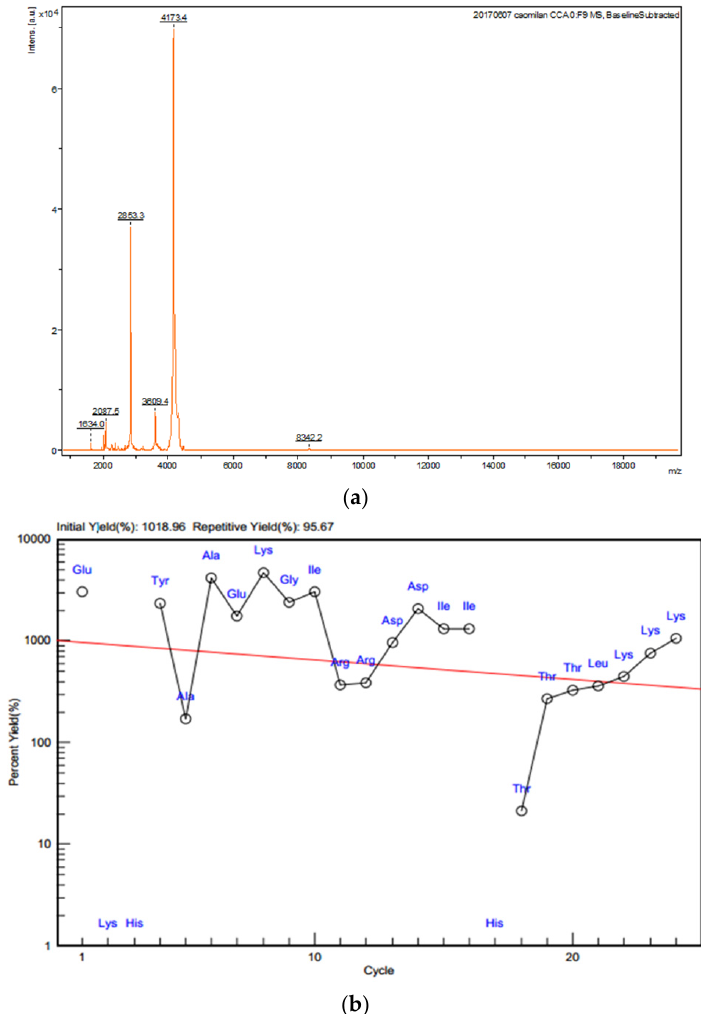
Figure 5. Molecular weight and amino acid sequence of active peptide. ( a ) Molecular weight of the active peptide determined by MALDI-TOF-MS. ( b ) N -terminal amino acid sequence of active